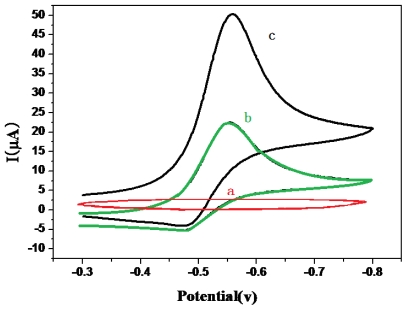
Cyclic voltammograms of (a) GCE/Ab1 in PBS (pH 7.0) and (b) GCE/Ab1/CEA and (c) GCE/Ab1/CEA/(DNA/(ZMPs-HRP-CEA Ab2)n) in PBS containing 5 mmol/L H2O2.